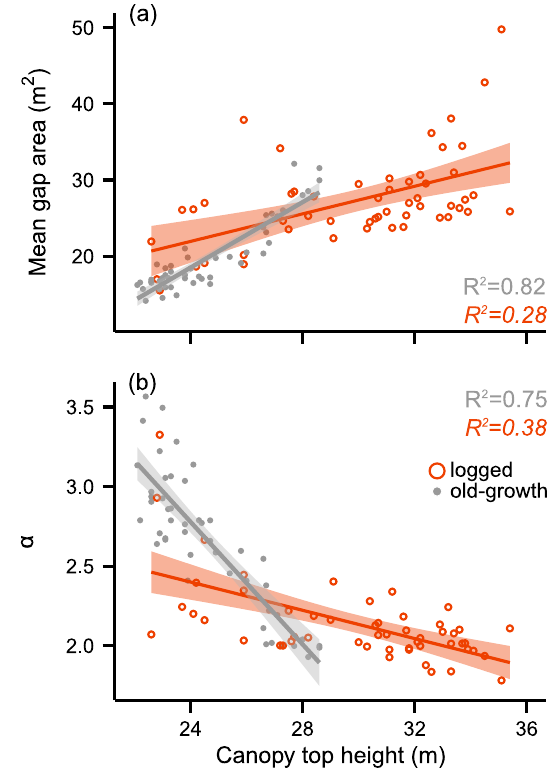
Figure 5. (a) Mean gap sizes and (b) scaling exponent α of the GSFD in relation to canopy top height in old-growth and logged peat swamp forest plots. Data are shown for the 8m cross-section. Fitted regression lines are plotted with 95% confidence intervals and the R 2 of the regression is given (italic for